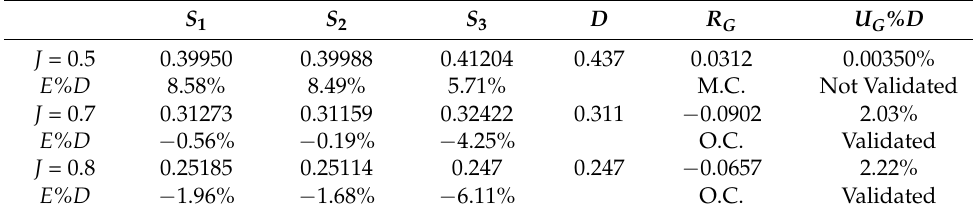
Table 7. Grid independence test result for KQ